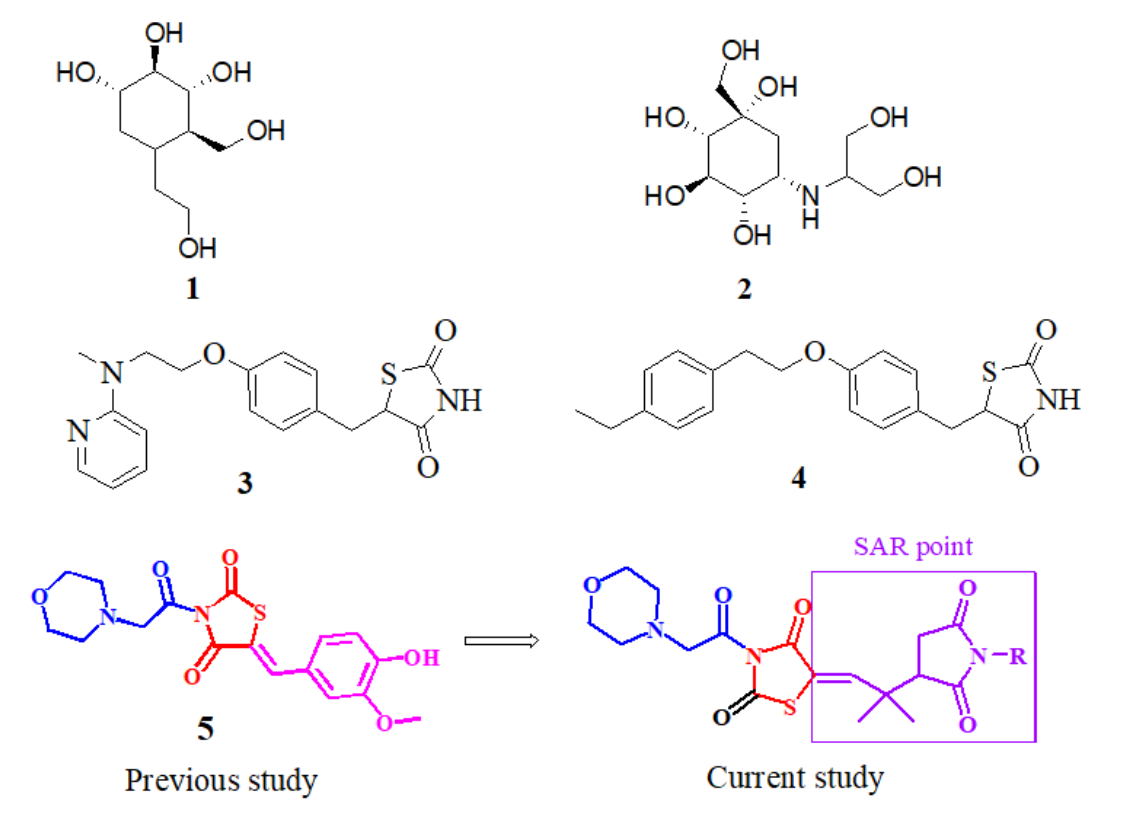
Figure 1. Miglitol ( 1 ), voglibose ( 2 ), rosiglitazone ( 3 ), pioglitazone ( 4 ), previously reported com- pound ( 5 ), and our currently designed compounds.